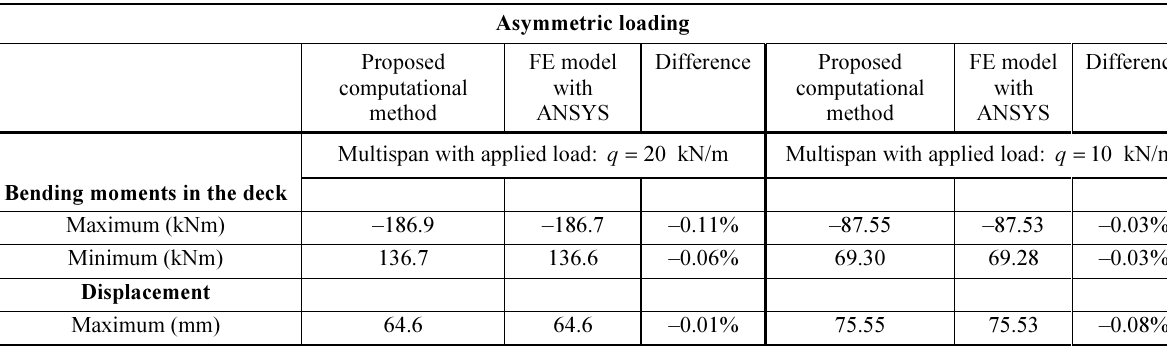
Table 2. The results of the numerical